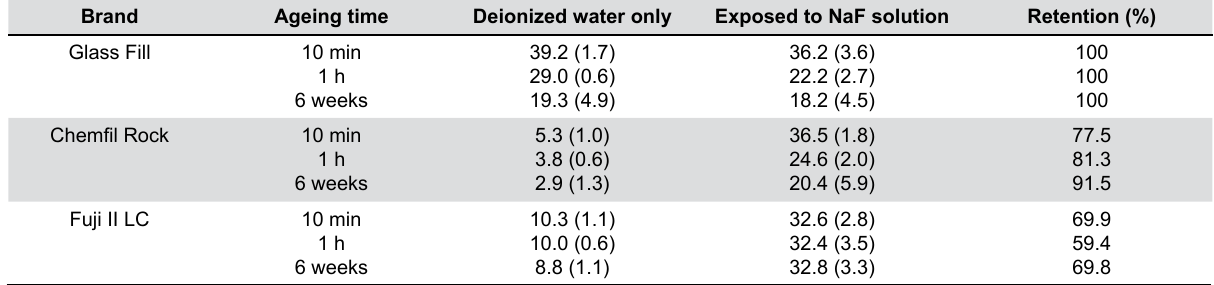
Table 3- Fluoride retention (%) by